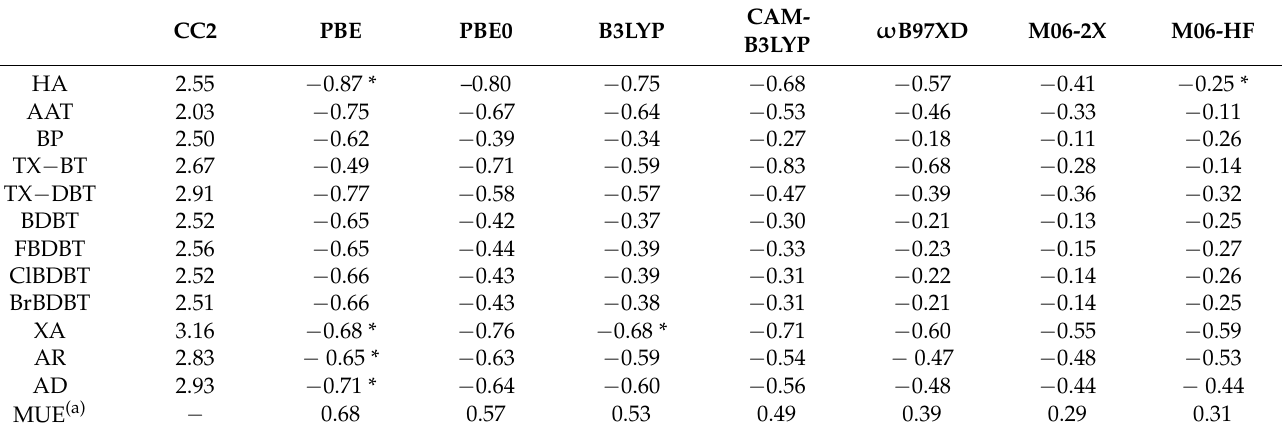
Table 2. The energy differences ∆ E (in eV ) relative to CC2 for the phosphorescence energy of AQs were calculated by TD//UDFT with different functionals (PBE, PBE0, B3LYP, CAM-B3LYP, ω